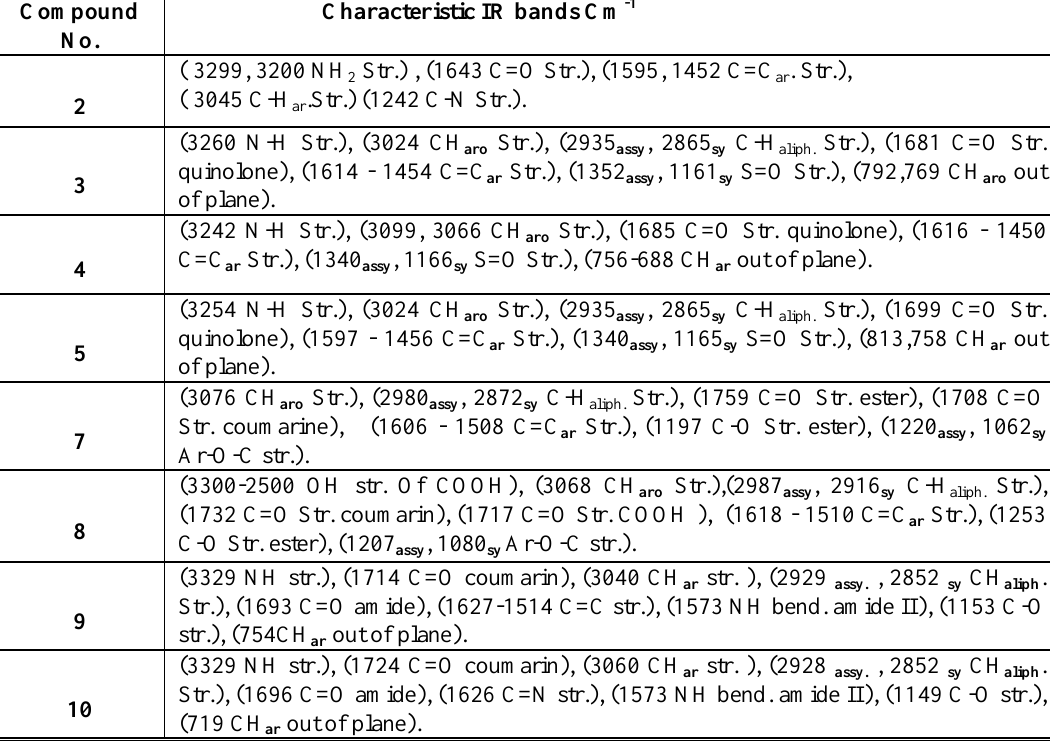
Table 3: The characteristic IR bands of synthesized compounds.